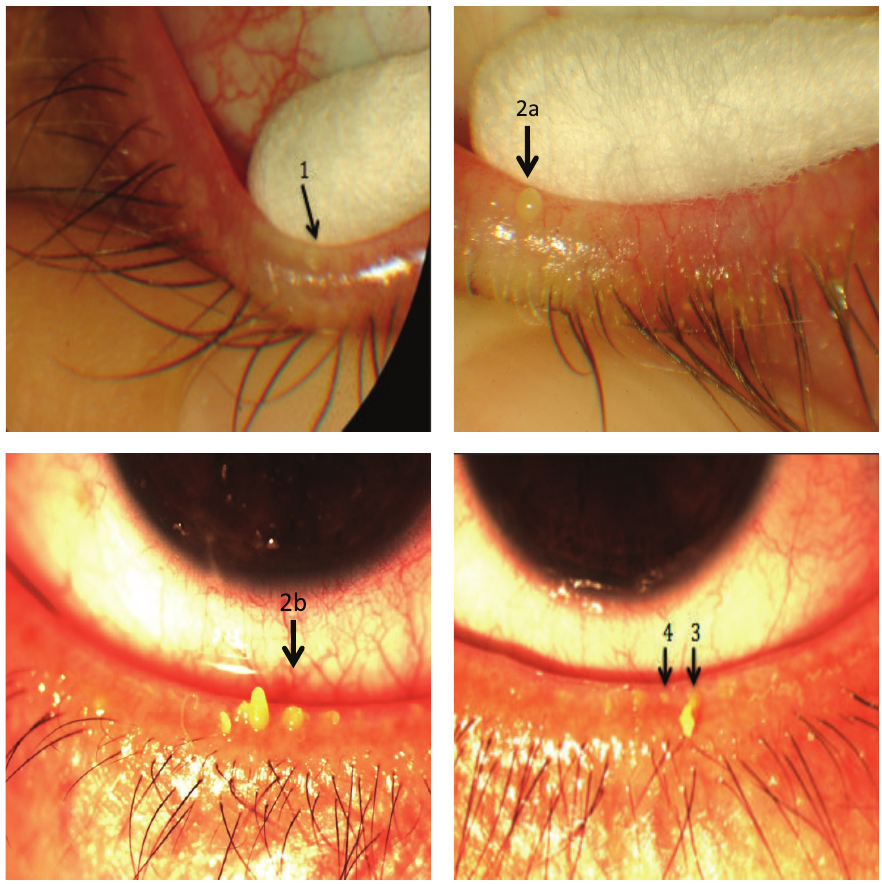
Figure 1: Demonstration of the severity of the COTE as seen by the clinician at the slit lamp, as described in Table 1.